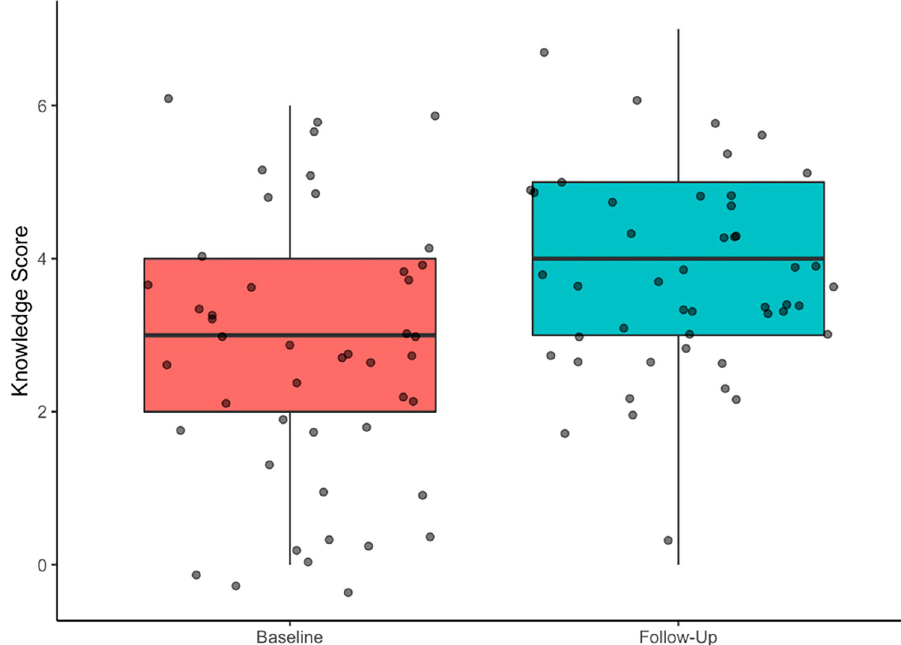
Fig 4. Distribution of knowledge scores at baseline and follow-up among 46 HBV-positive women who participated in both studies. Average score at baseline was 2.8 (range 0–6) and average score at follow-up was 3.7 (range 0–7) (p <